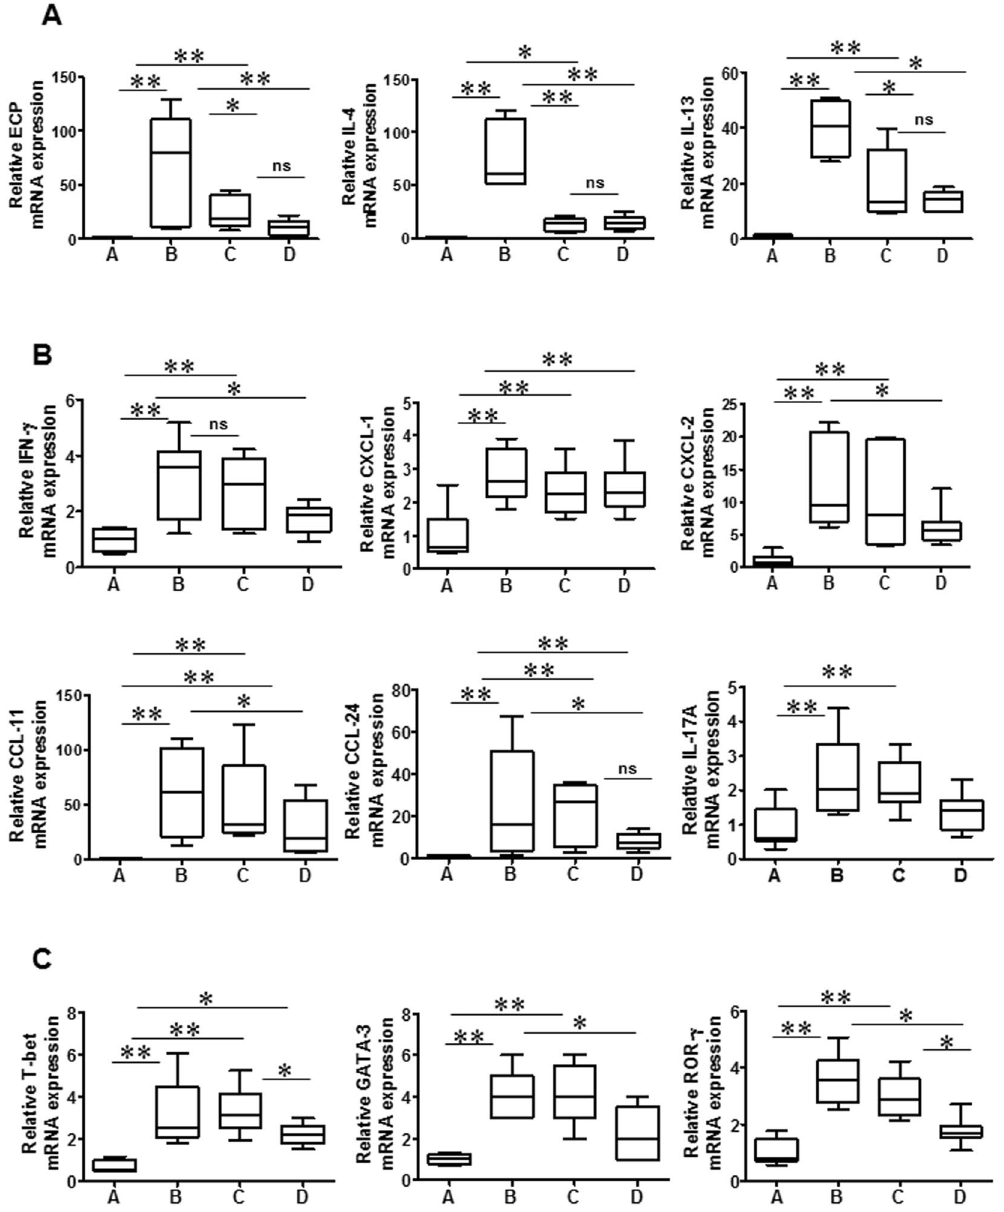
Figure 7. Wogonin suppresses mRNA expression of ECP, IL-4, and IL-13 in the mouse polyp model. ( A – C ) Relative mRNA expression levels of ECP, IL-4, IL-13, IFN- γ , IL-17A, CXCL1, CXCL2, CCL11, CCL24, T-bet, GATA3, and ROR- γ were measured in nasal tissues from the mouse polyp model. Groups A–D are defined as shown in Fig. 4. Data are expressed as the means ± SD. * P < 0.05, ** P < 0.01. Mann-Whitney U